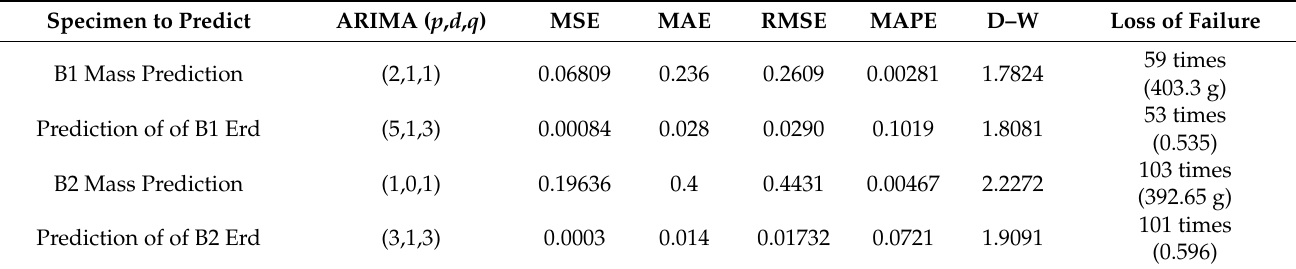
Table 4. ARIMA model was selected to predict the damage and failure of sulfate erosion specimens. Specimen to